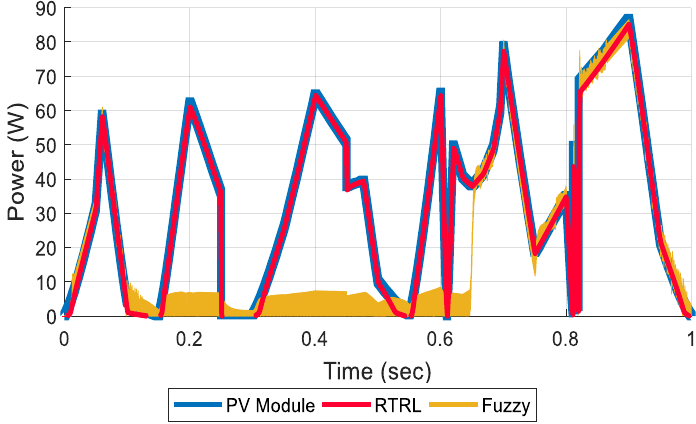
Figure 21. Results obtained with the RTRL and Fuzzy controllers for variable signals of irradiance and temperature.